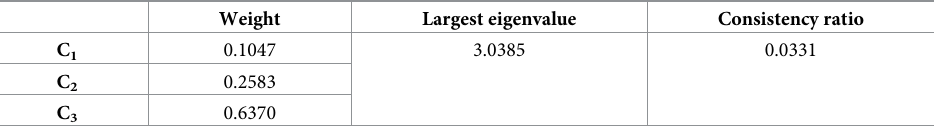
Table 17. Values of the consistency ratio and fuzzy weight vectors and crisp weights in emergency response 2.